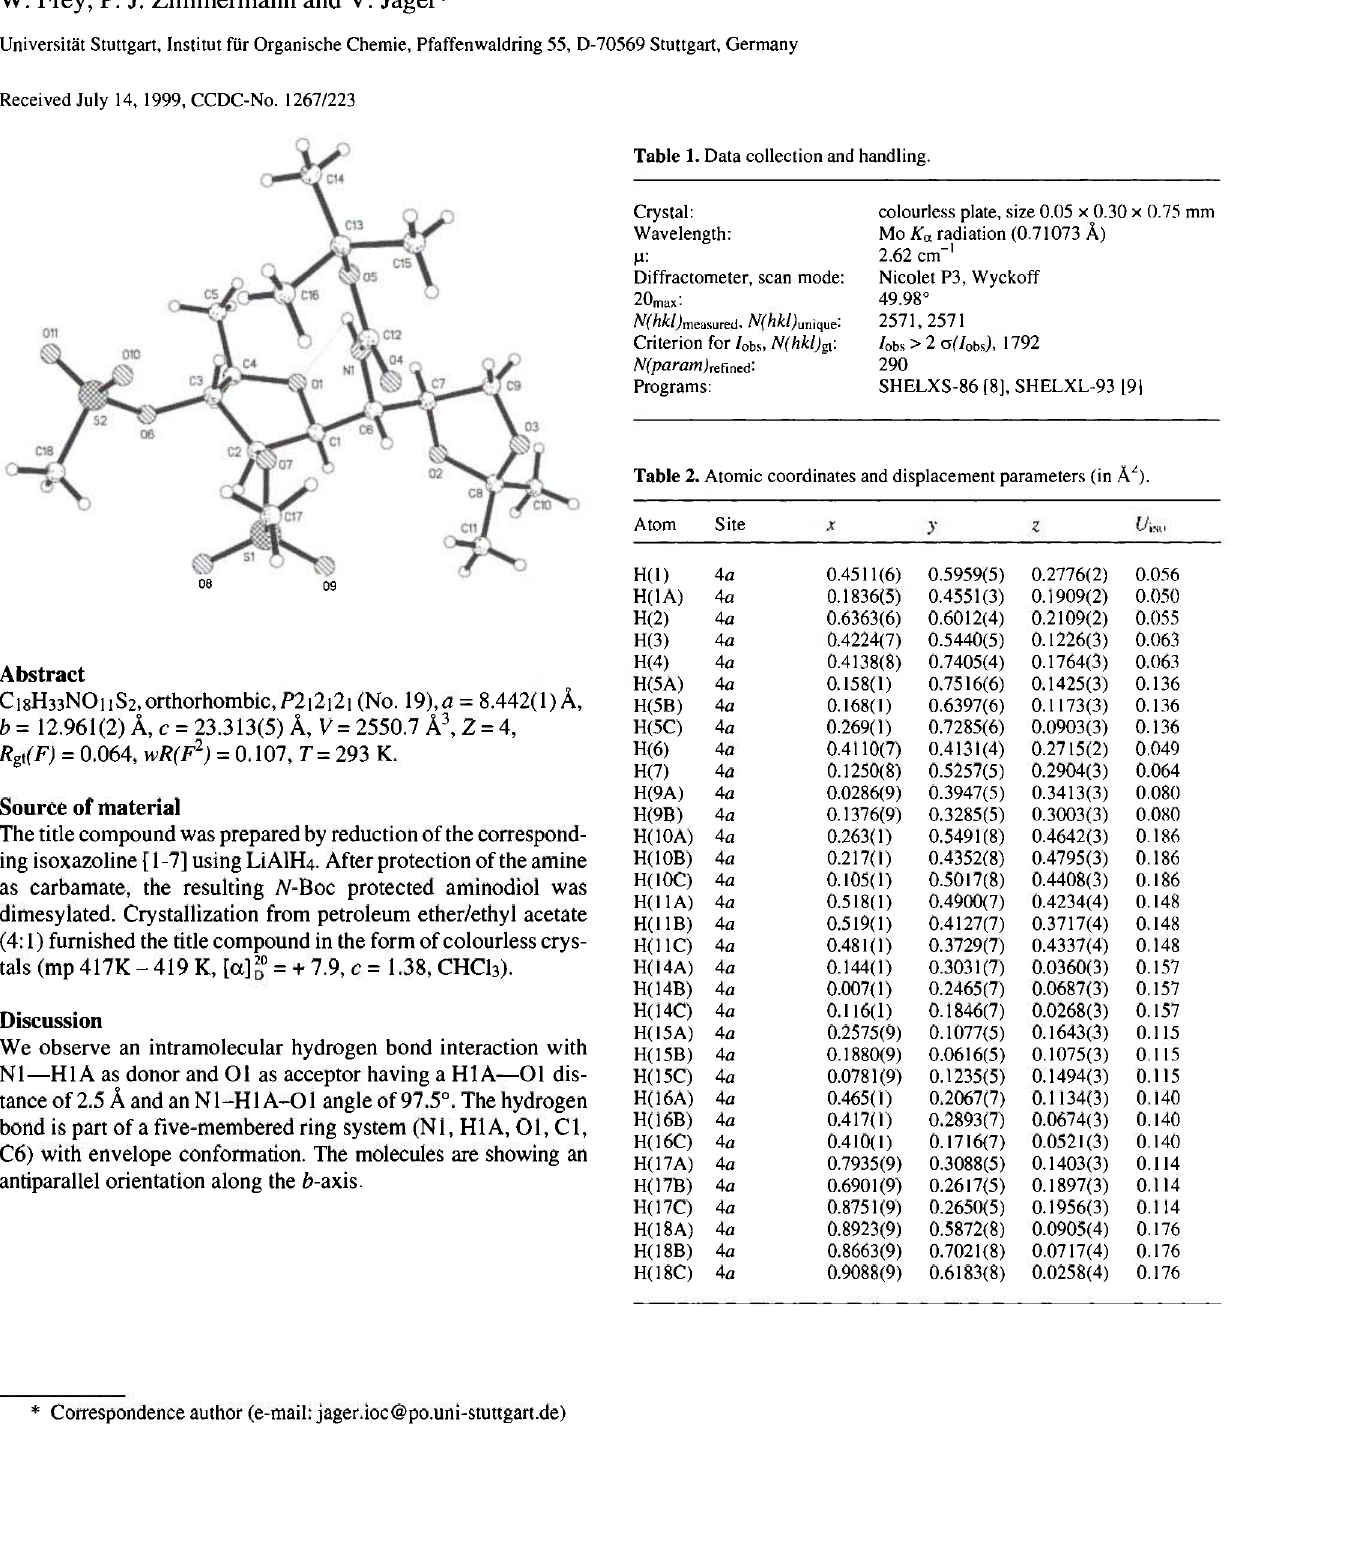
Table 1. Data collection and handling.